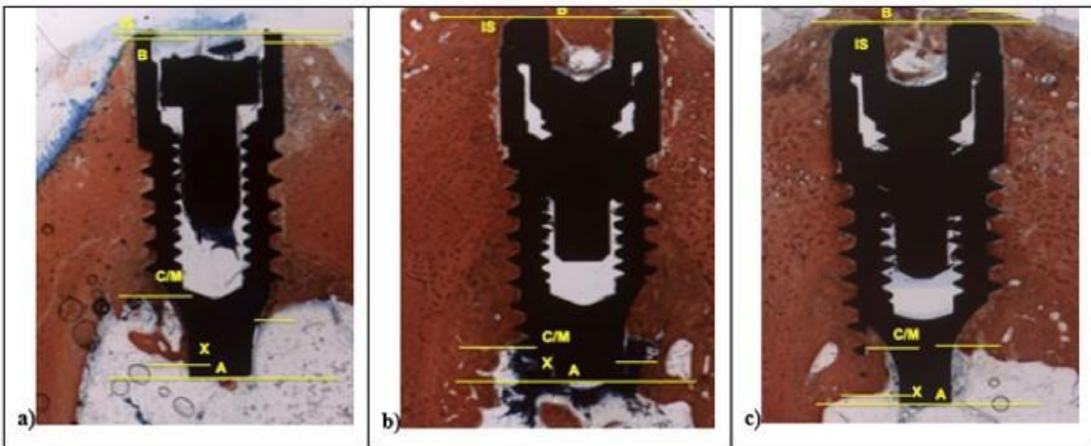
Figure 7. After 30 days, histological analysis of SBAE ( a ), L1 ( b ), and L2 ( c ) of the osseointegration healing process (100 × magnification).